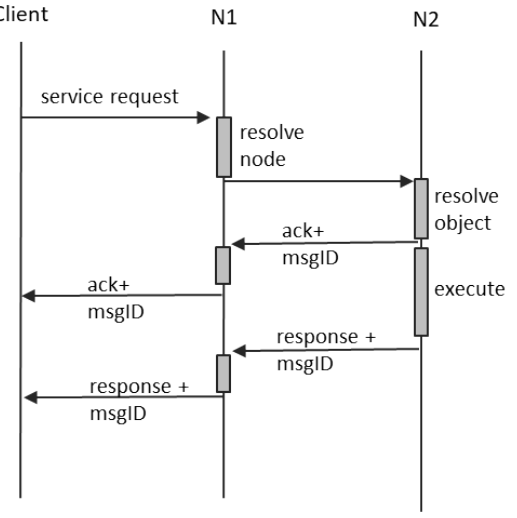
Figure 6. Service request